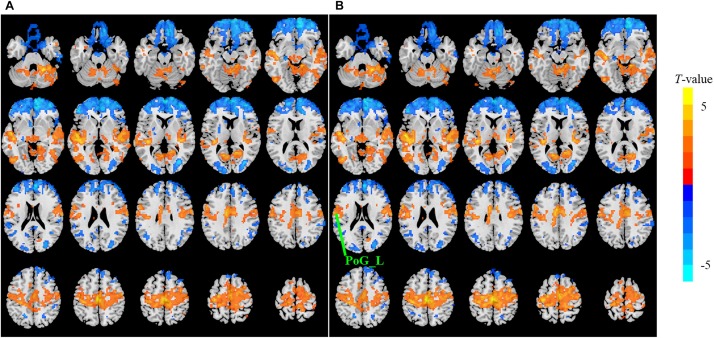
The t map (p < 0.05, cluster size ≥ 10 voxels) of eyes closed (EC) versus eyes open (EO) in the conventional band (0.0117–0.0781 Hz) by FFT-ALFF (A) and db2-ALFF (B), respectively. Warm colors indicate higher ALFF in EC conditions. ALFF, amplitude of low-frequency fluctuation; FFT, fast Fourier transform; PoG_L, left postcentral gyrus.